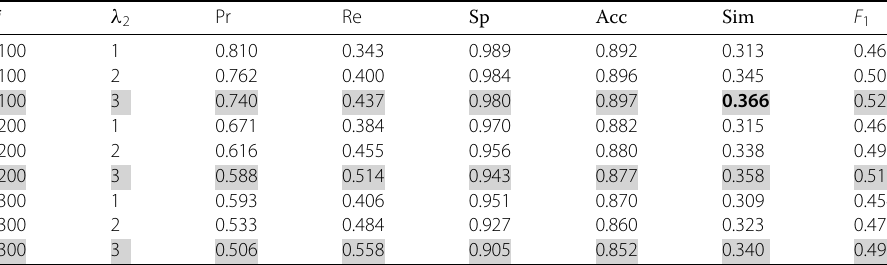
Table 5 Evaluation results for MACWE with λ 1 = 1 fixed i λ 2 Pr Re Sp Acc Sim F 1 100